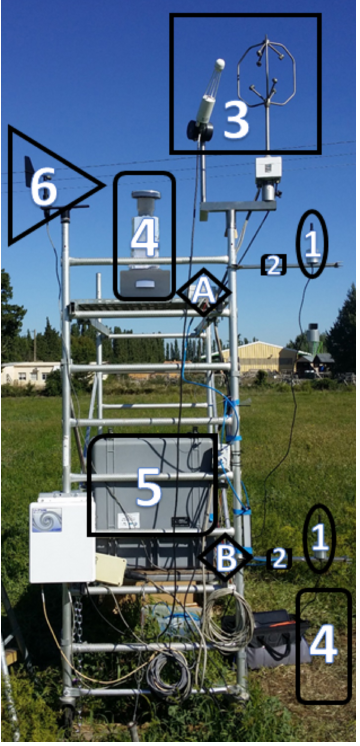
Figure 1. Schematic representation of the sampling station: each piece of equipment is represented by a number (in bold face) and the position of the equipment; all values in this caption are ex- pressed in centimeters above ground level. Cup anemometers (1; 80 and 210), thermocouples (2; 80 and 210), sonic anemometer and Li-7500 open-path gas analyzer (3; 300), Burkard air samplers (4; 75 and 255; the bottom one is not in place in the figure, but the rect- angle indicates its approximate position), Li-7000 differential gas analyzer (5; with inlets at 55 A and 200 B), and wind vane (6;